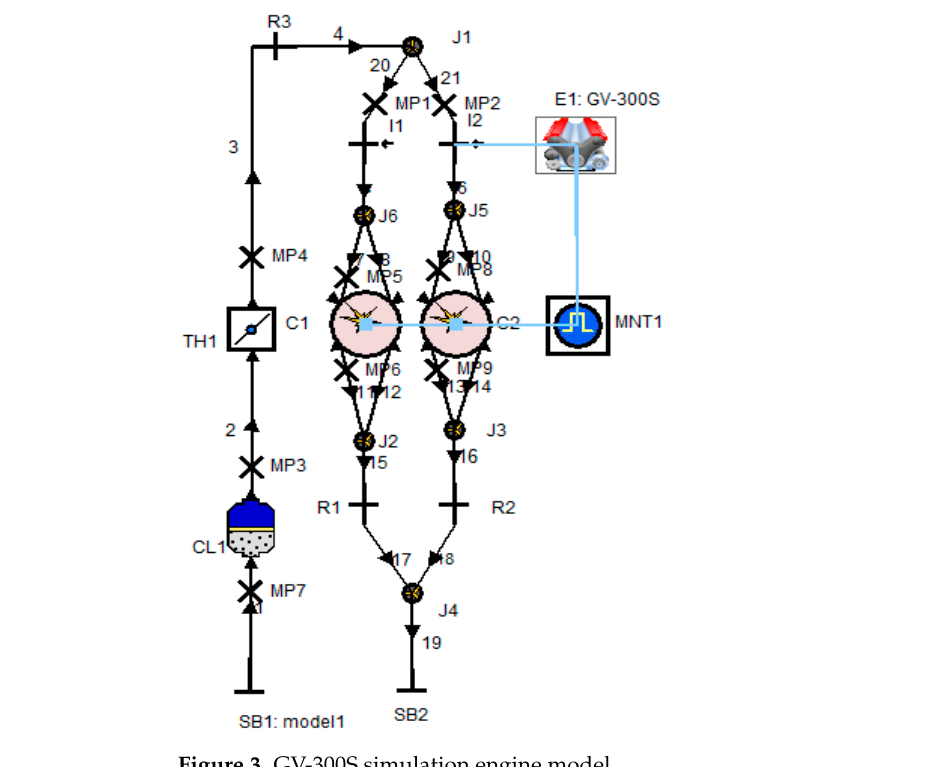
Figure 3. GV-300S simulation engine model.